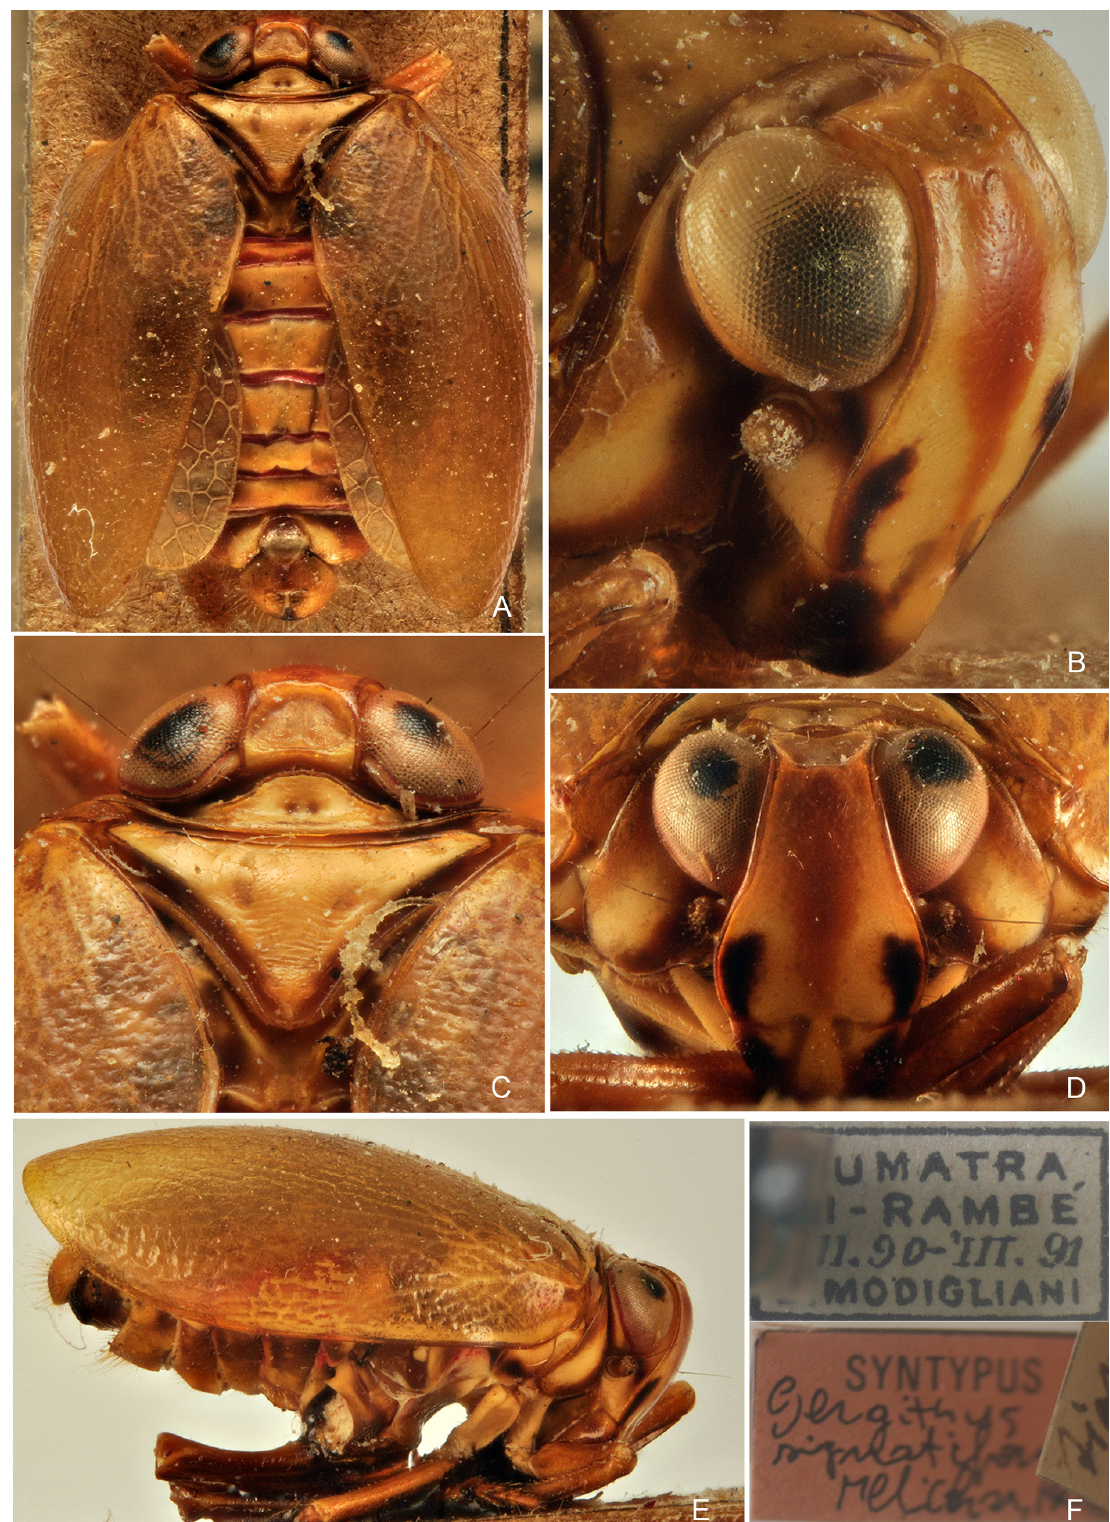
Fig. 6. Gergithus signatifrons Melichar, 1906 , syntype. A . Habitus, dorsal view. B . Metope and clypeus, frontolateral view. C . Head and thorax, dorsal view. D . Metope and clypeus, facial view. E . Habitus, lateral view. F .